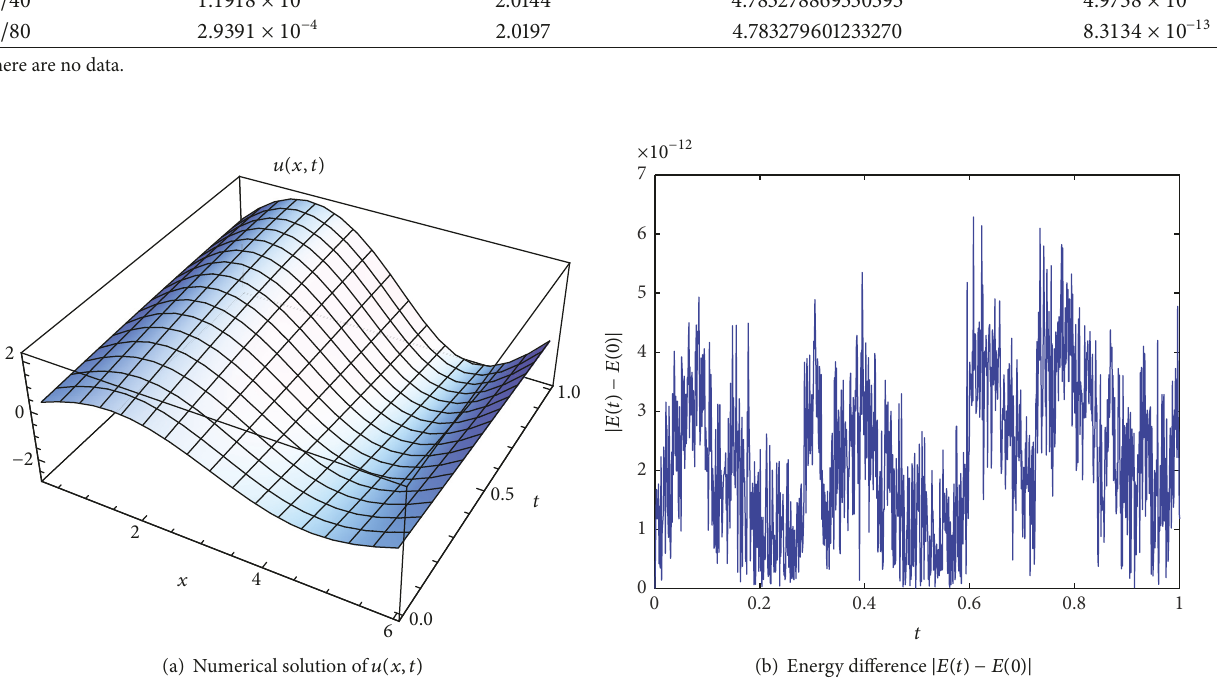
Figure 1: (a) Space-time graph of numerical solution and (b) the energy difference |𝐸(𝑡)−𝐸(0)| in each time level of the problem with different ℎ = 𝜋/40 , 𝑇 = 1 , and 𝜏 = 0.05 .